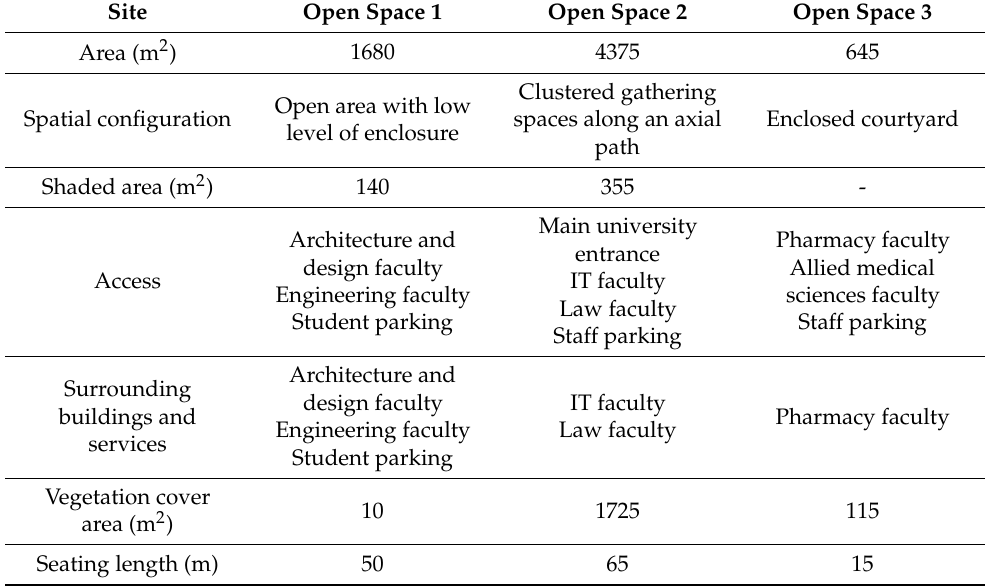
Table 2. Summary of the three open